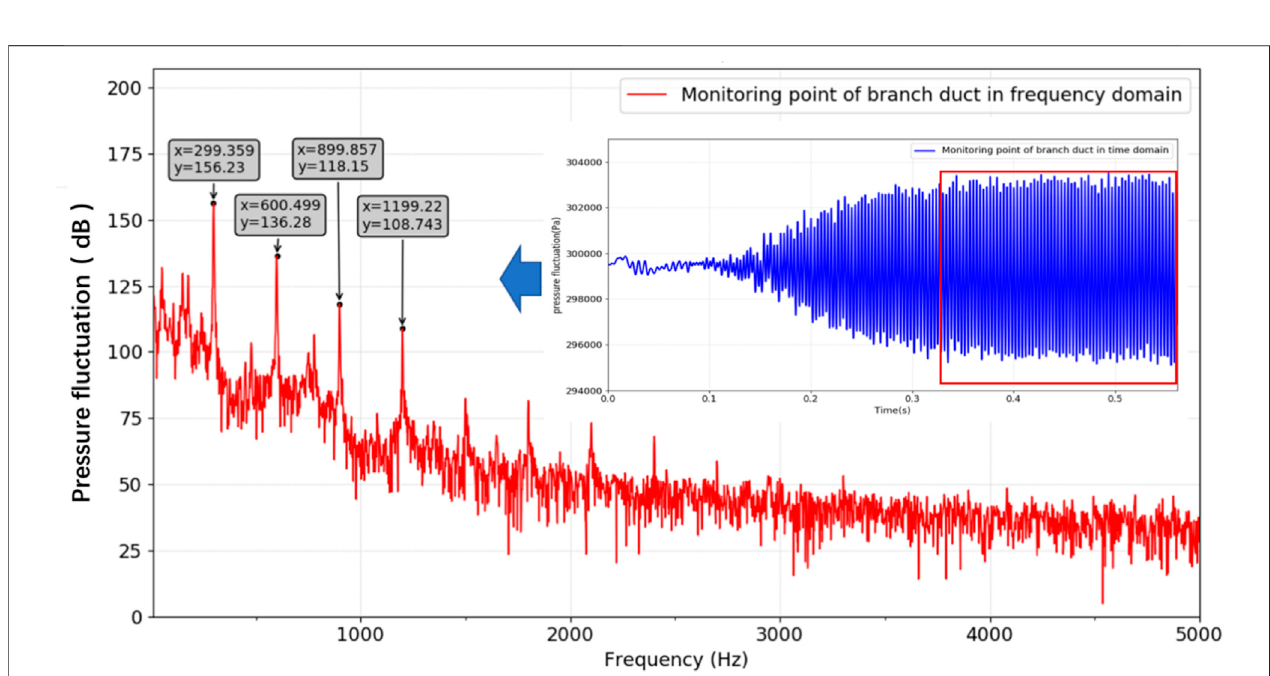
FIGURE 7 | Pressure fl uctuation across time (blue) and frequency (red).